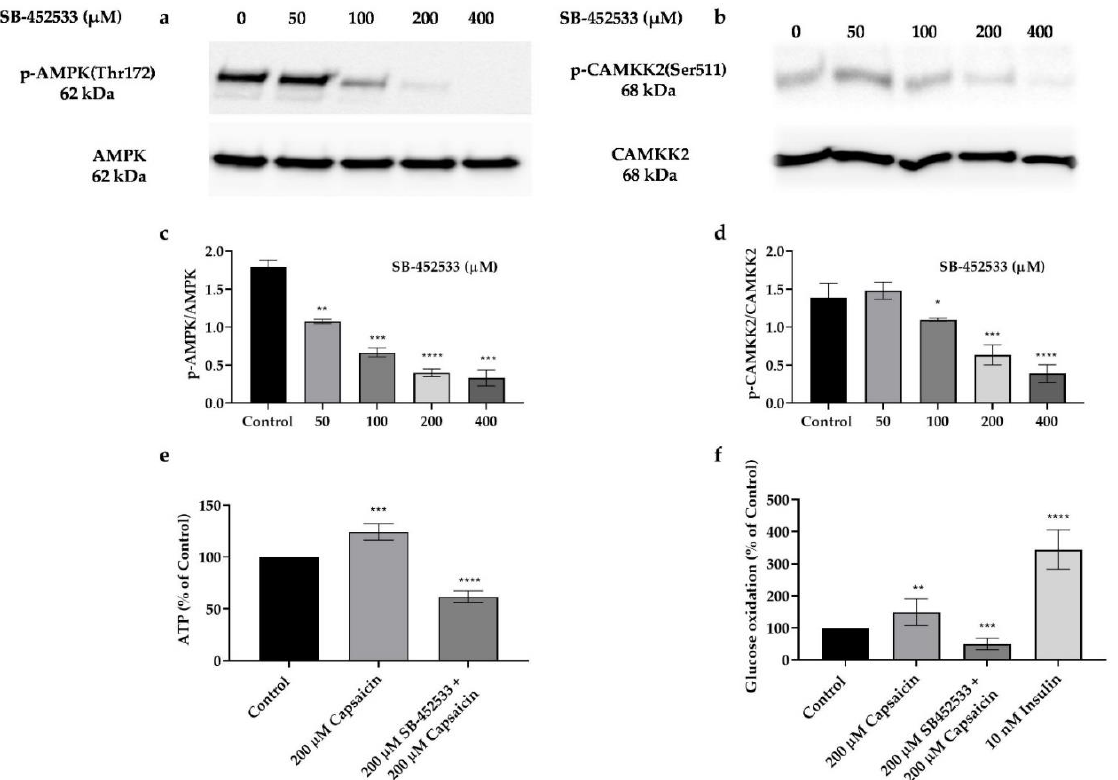
Figure 7. Western blot analysis for phosphorylated and total AMPK and CAMKK2, glucose oxidation and intracellular ATP levels in SB-452533 and capsaicin treated mouse skeletal muscle cells . ( a – d ) Western blot and densitometric analysis of p-AMPK, AMPK, p-CAMKK2, and CAMKK2 with increasing concentrations of SB-452533 in the presence of 200 µ M capsaicin. ( e ) Intracellular ATP level in the 0 and 200 µ M capsaicin treated myotubes in the presence or absence of 200 µ M SB-452533. ( f ) Glucose oxidation percentage in 200 µ M capsaicin treated myotubes in the absence or presence of 200 µ M SB-452533 and 10 nM insulin after 60 min incubation time. Data are presented as mean ± SD of three independent repeats ( n = 3). * p < 0.05, ** p < 0.01, *** p < 0.001, and **** p < 0.0001 indicate a significant difference between control and SB-452533-treated groups.